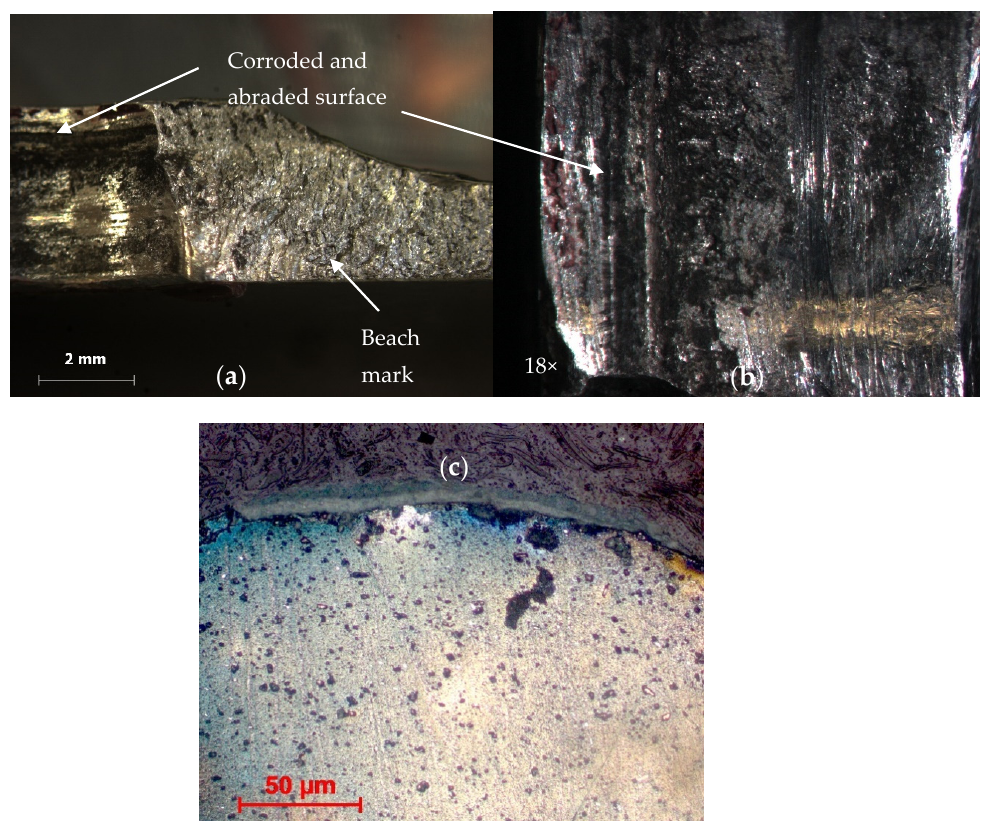
Figure 9. Fracture surface due to corrosion and fatigue. ( a ) Beach mark and corrosion of frame X7225 of EC725. ( b ) Close up image (18×) on the specimen. ( c ) Close up image of C130H lower skin area.